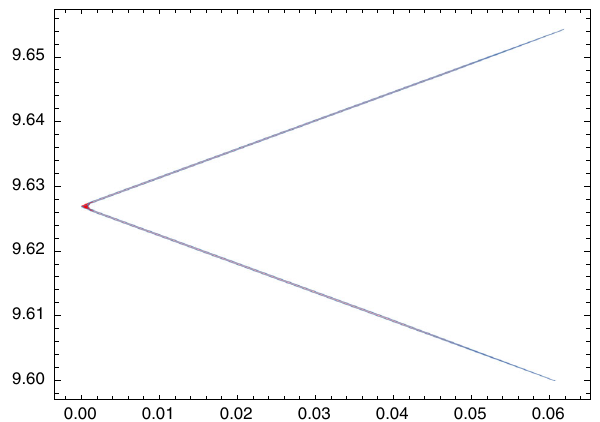
Fig. 10 Parametric plot of n s vs r ( x axis ≡ r and y axis ≡ 10 n s ) for 0 . 001 ≤ (cid:13)/ H 0 ≤ 0 . 02, 82 ≤ βμ 2 /(cid:13) ≤ 83 with κ H 0 ∼ 0 . 01